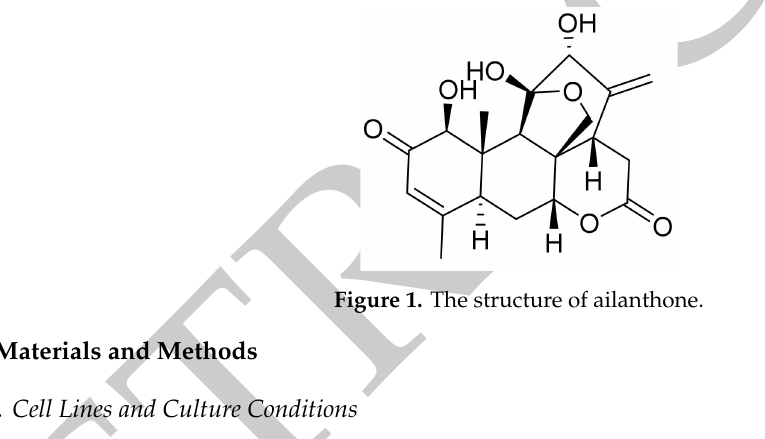
Figure 1. The structure of